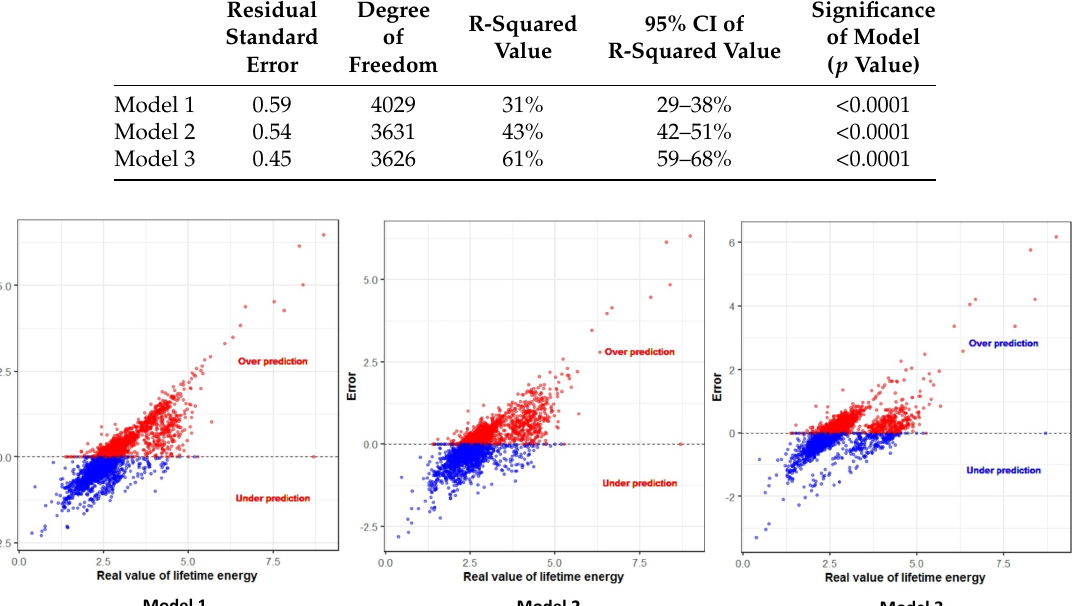
Figure 6. Comparison of the trends of prediction using three models to predict the energy yield. The predicted value is called over prediction if it is higher than the real value (error > 0 ), the other is called under